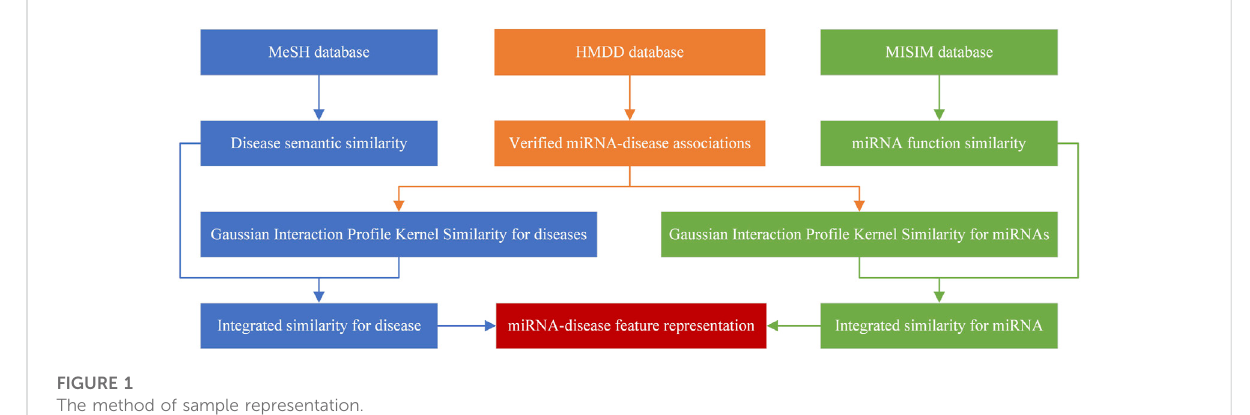
FIGURE 1 The method of sample representation.